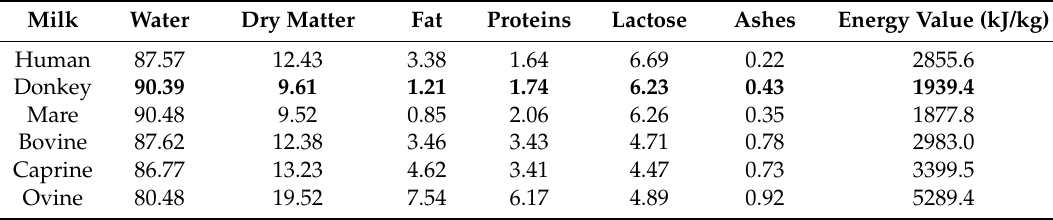
Table 4. Percentage composition (g/100 g) of donkey milk (evidenced in bold) and comparison with other